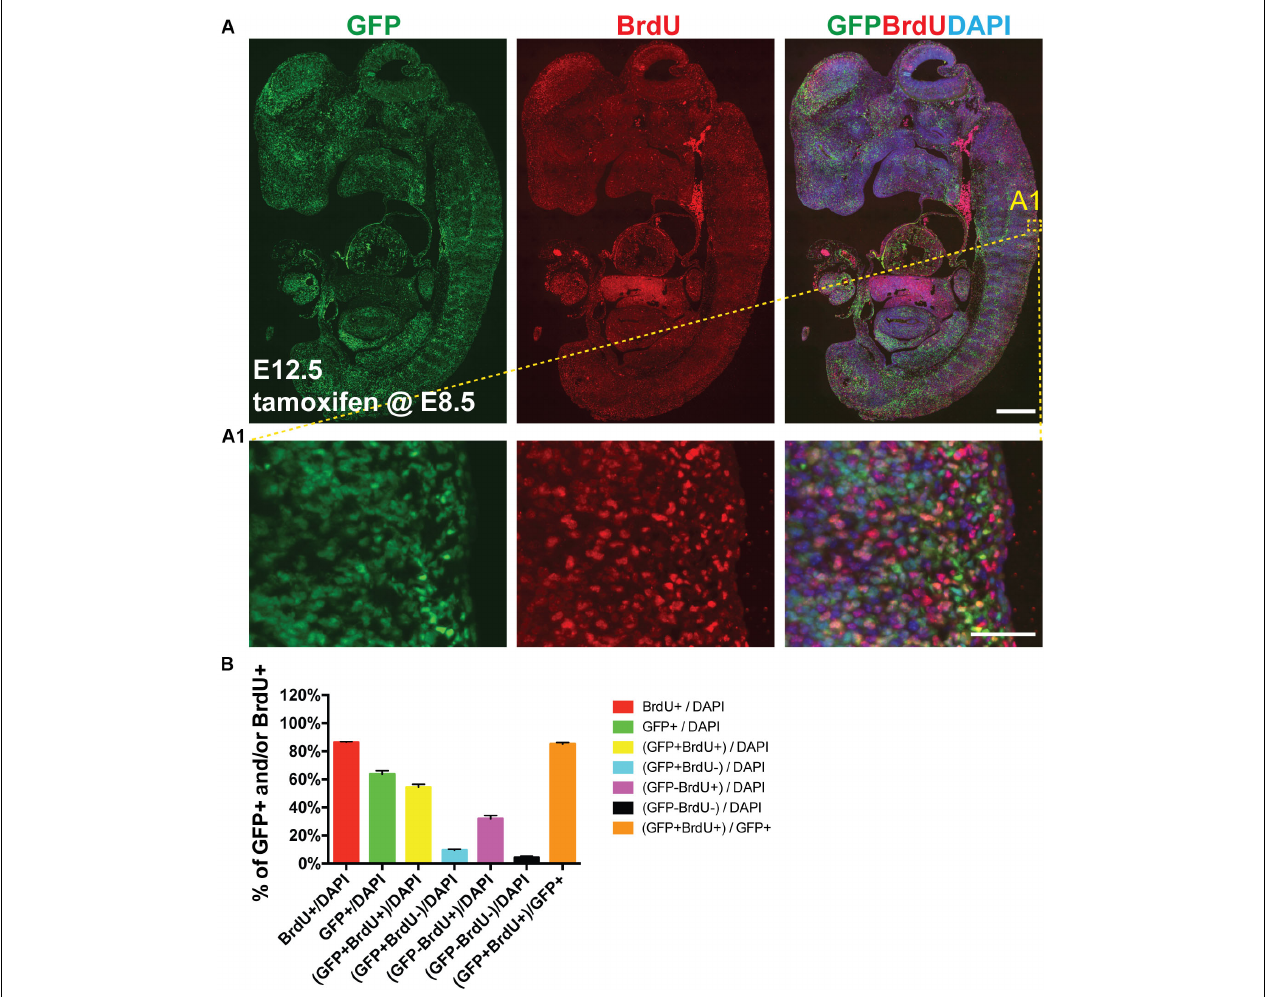
FIGURE 5 | Aurkb ER Cre / + labels proliferating cells in developing embryos. Tamoxifen (150 mg/kg BW) was given to pregnant mice at E8.5 by gavage. BrdU (100 mg/kg BW) was intraperitoneally given to pregnant mice for four consecutive days (E8.5, E9.5, E10.5, and E11.5, one injection/day). (A and A1) Representative immunofluorescence micrographs of an E12.5 Aurkb ER Cre / + ; R26R eYFP / + embryo (sagittal section). Scale bars, A, 500 µ m; A1, 50 µ m; (B) Labeling quantification of Aurkb ER Cre / + and/or BrdU ( n =